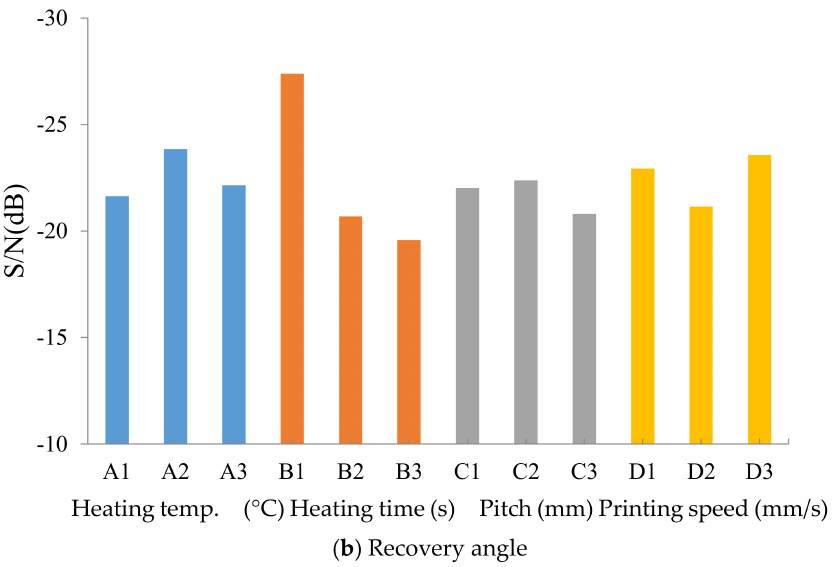
Figure 10. Variations in the signal to nose (S/N) ratio with a factor level for shape changes of the stimulus-responsive composite material.